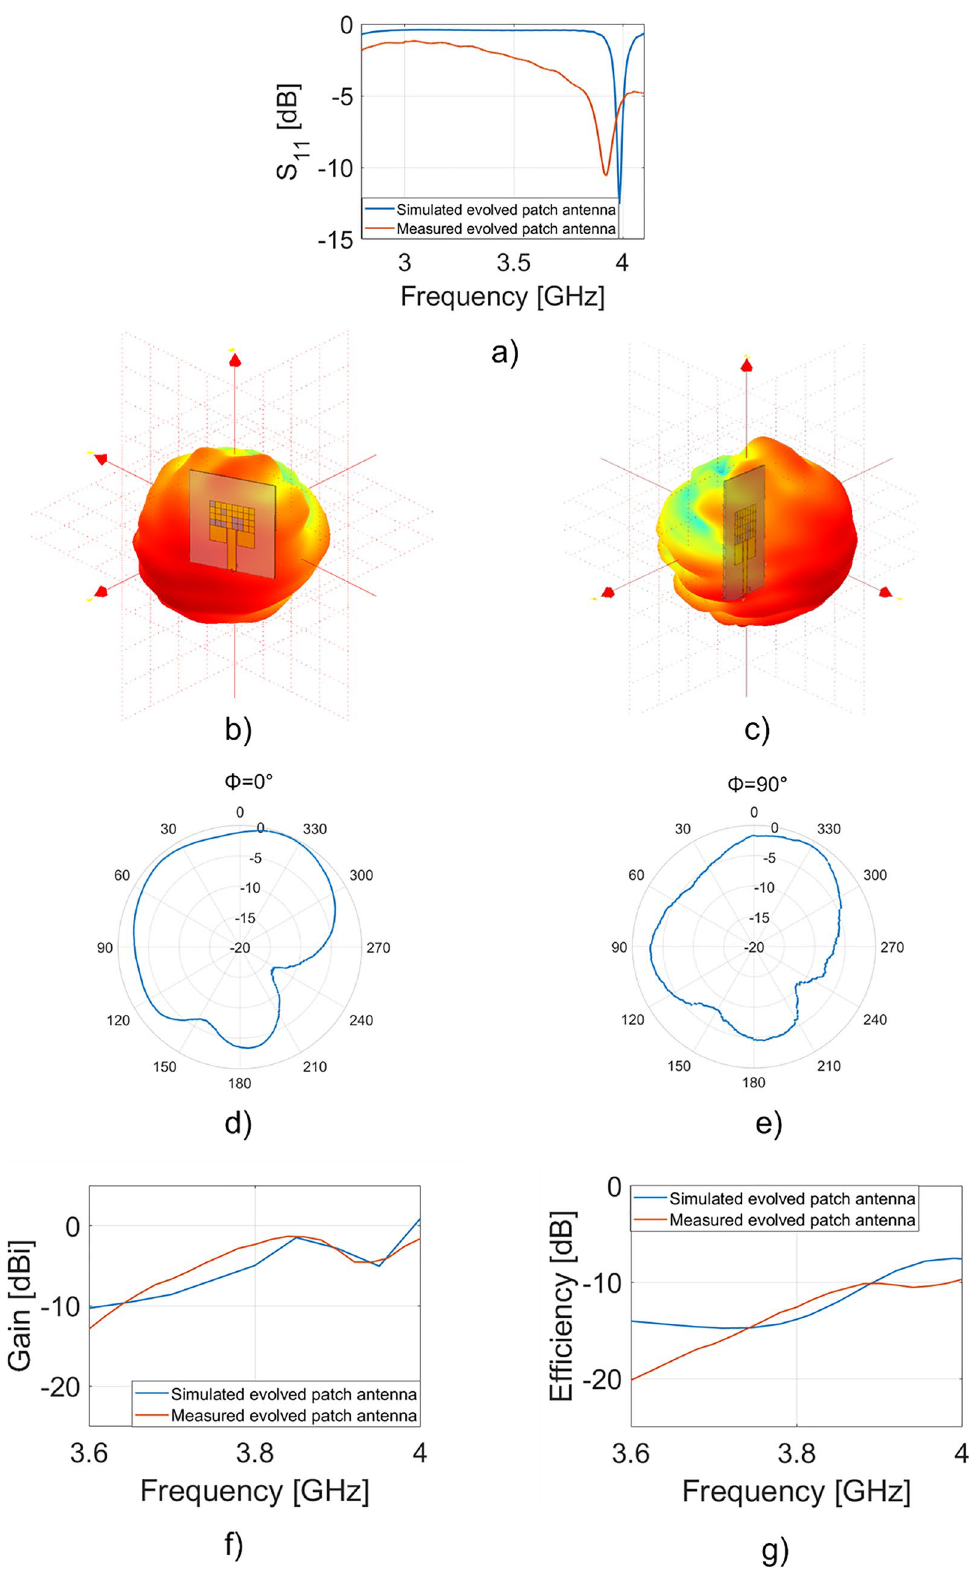
Figure 6. ( a ) Simulated (blue curve) and measured (red curve) S 11 parameter of the multilayer antenna, measured ( b ) front perspective and ( c ) side perspective 3D radiation patterns; polar plot at ( d ) ϕ = 0° and ( e ) ϕ = 90° at 4 GHz; simulated (blue curve) and measured (red curve) ( f ) gain and ( g ) efficiency of the evolved patch antenna. Software used: proprietary software by Starlab from Satimo 18 GHz anechoic chamber, https:// www. mvg- world. com/ en/ produ cts/ anten na- measu rement/ multi- probe- syste ms/ starl